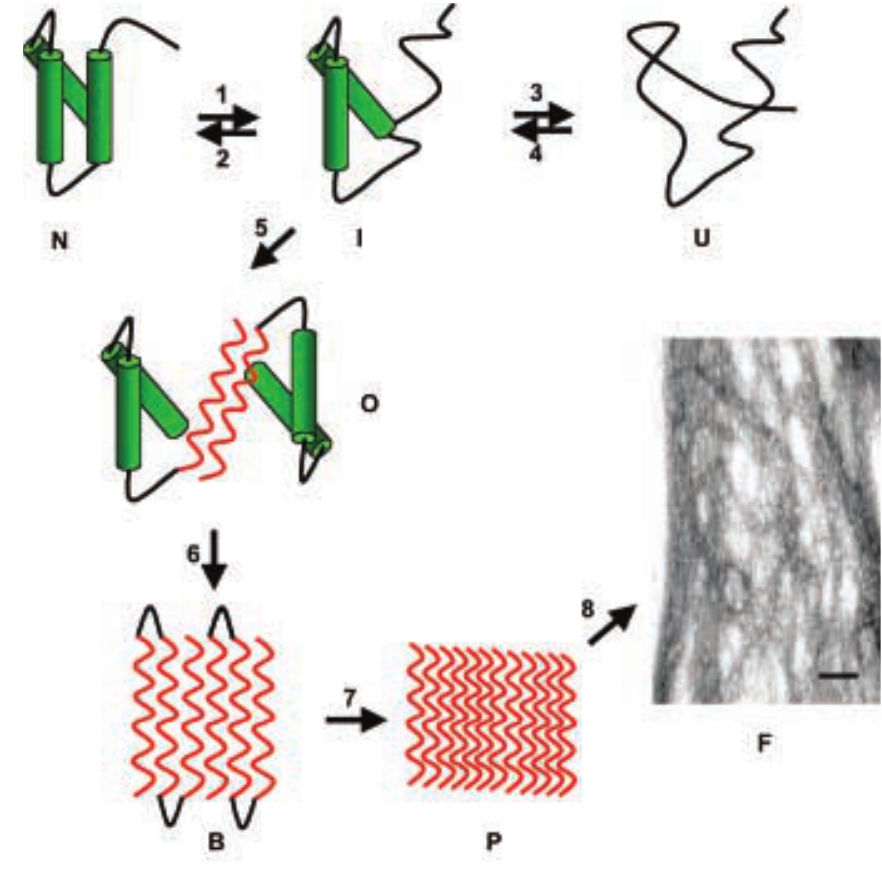
Figure 1 Pathway for formation of amyloid fibrils . Schematic representation of the current under- standing of molecular mechanisms involved in fibril formation. N represents the native struc- ture, U a completely unfolded state, and I represents an intermediate in which parts of the polypeptide chain are in non-native confor- mation. Formation of intermolecular b -sheet mediated by unfolded regions in I leads to protein oligomerisation (O), which in turn leads to further formation of b -strand structure (B), formation of prefibrillar oligomers/protofibrils (P) and eventually to fibril formation (F). The scale bar in the electron micrograph represents 50